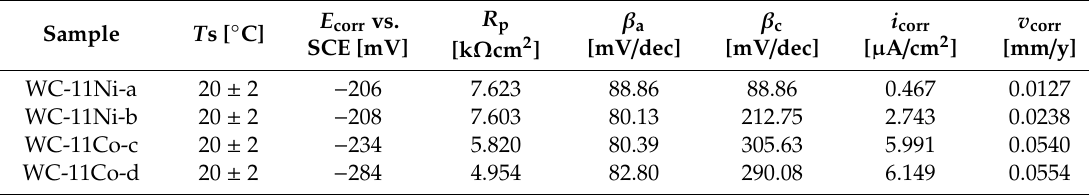
Table 2. The results of electrochemical DC techniques.